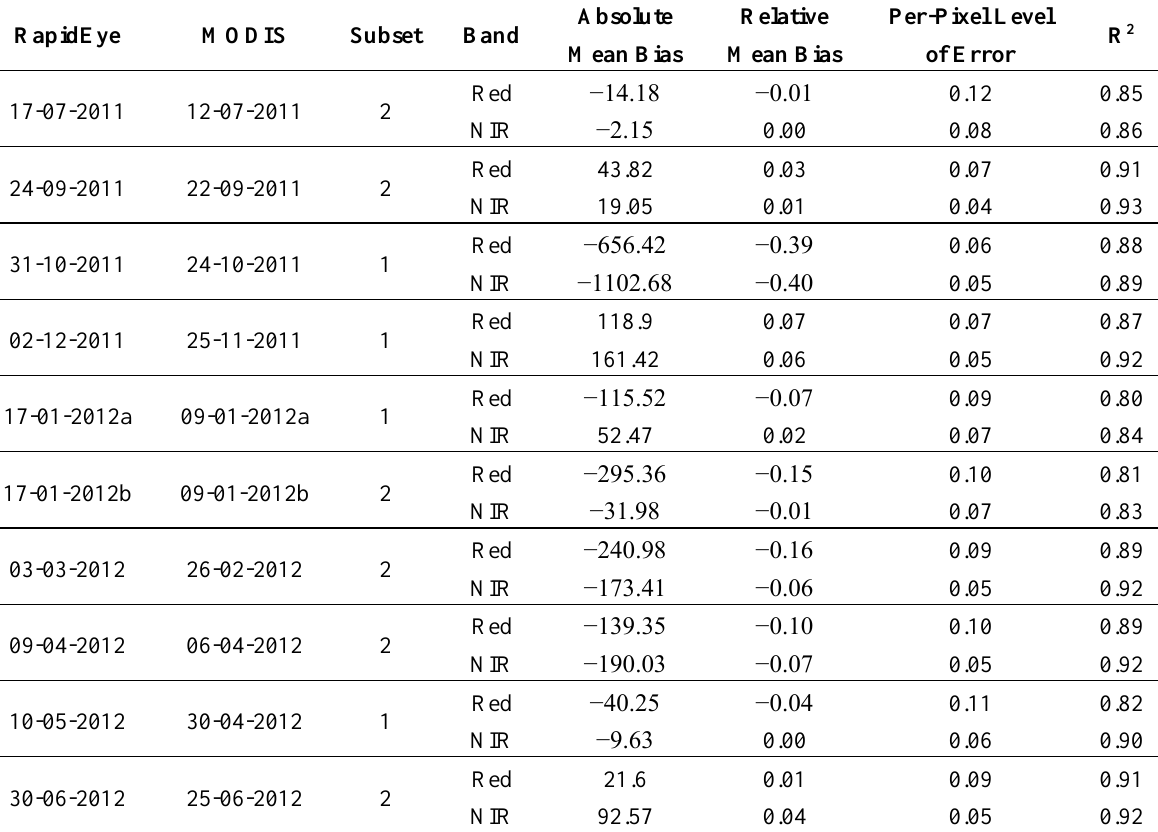
Table 2. Results for the pixel-based, band by band accuracy assessment of the RapidEye images against the ESTARFM computed predicted images. Numbers are rounded. Subset 1 has a sample size of 23,072,682 pixels, Subset 2 a size of 34,592,816 pixels. The Absolute Mean Bias is given in surface reflectance units.